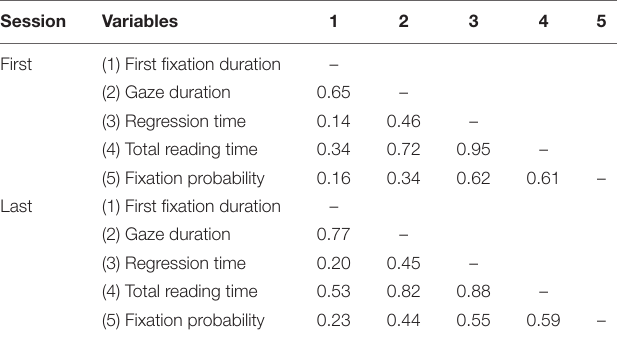
TABLE 1 | Correlations between the five eye tracking